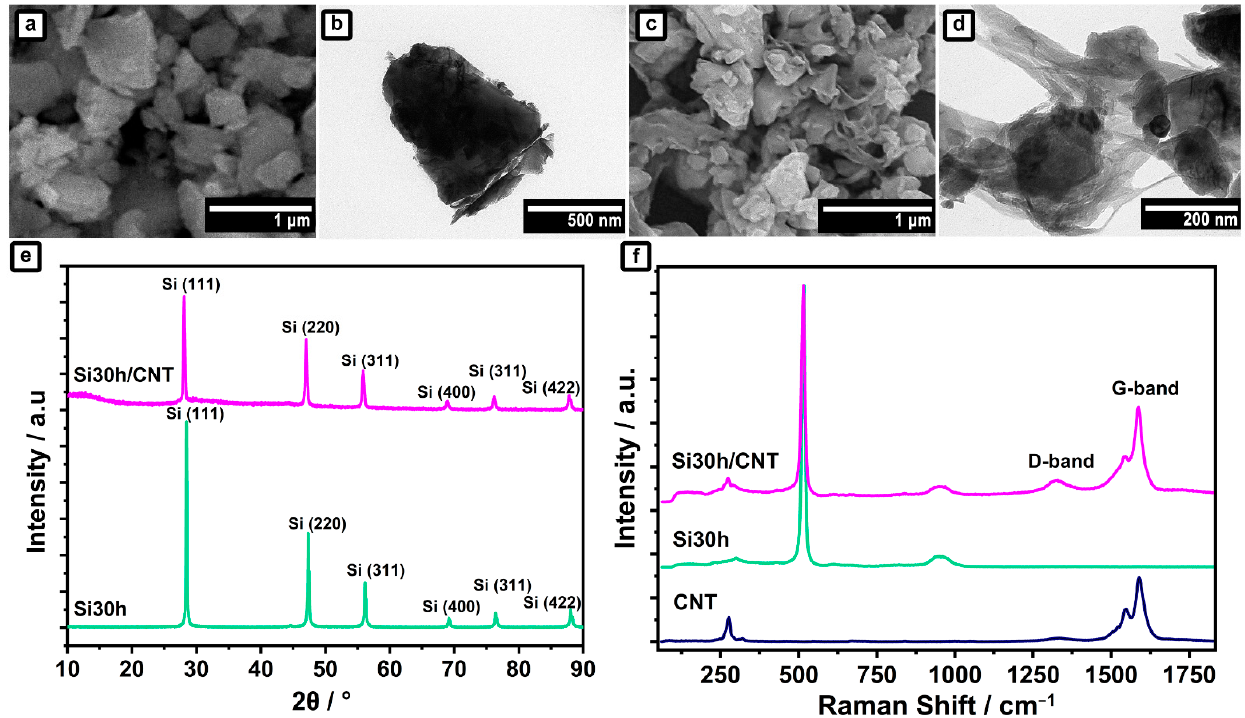
Figure 3. ( a ) SEM and ( b ) TEM images of Si30h; ( c ) SEM and ( d ) TEM images of Si30h/CNT; ( e ) XRD spectra of Si30h and Si30h/CNT; ( f ) Raman spectra of Si30h and Si30h/CNT. ( e ) XRD spectra of Si30h and Si30h/CNT; ( f ) Raman spectra of Si30h and